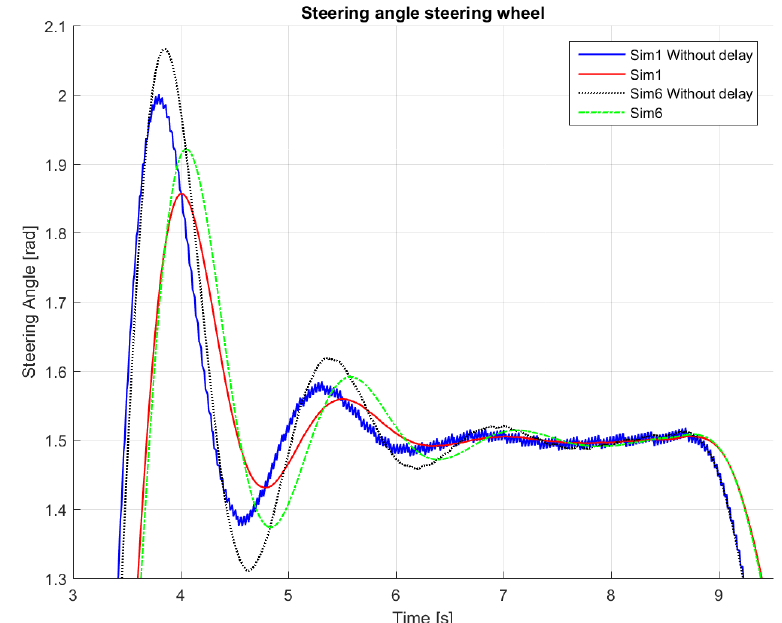
Figure 6. Angle of the steering wheel responses for evaluation of steering output.